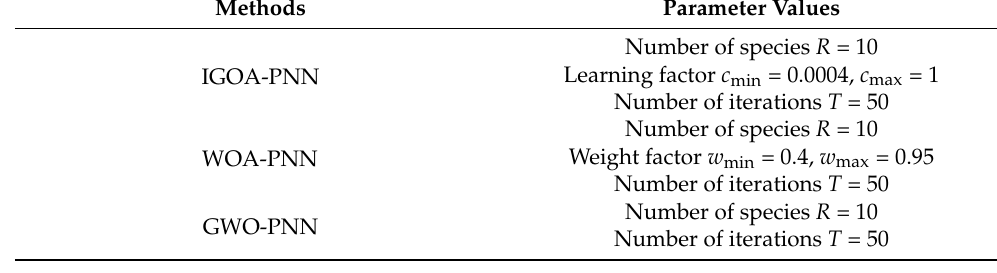
Figure 13. The recognition accuracy curves of different algorithms. Table 2. Main parameters of different algorithms.